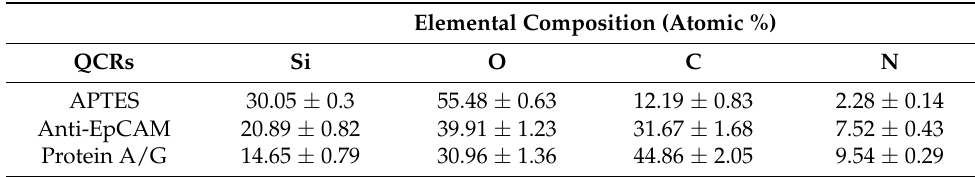
Table 2. Elemental composition calculated by XPS